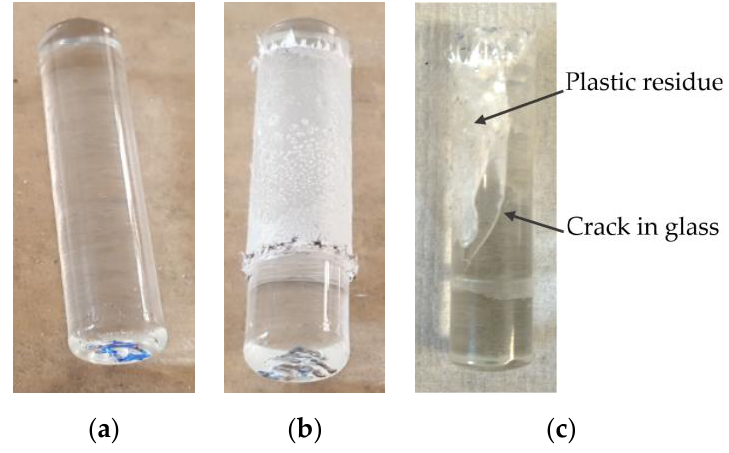
Figure 6. Failure patterns on glass substrates ( a ) clean rod; ( b ) layer from treated powder intact after the strength test; ( c ) plastic residue on the glass surface and cracked glass.